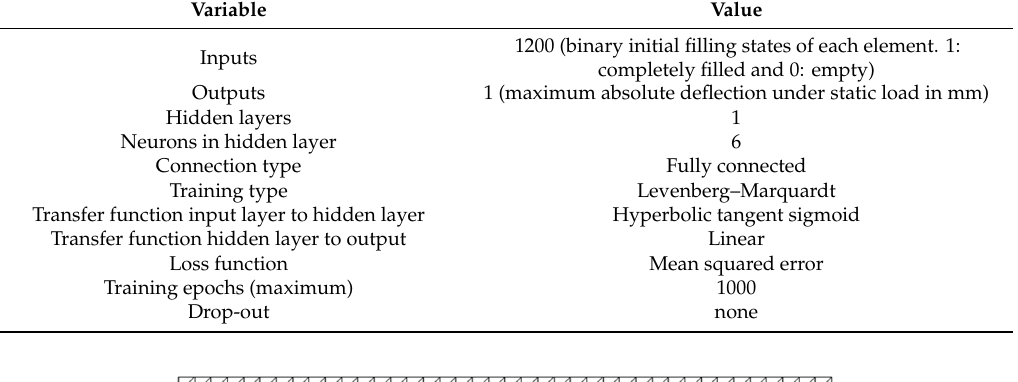
Figure 3. Shear rate and temperature-dependent viscosity [59].